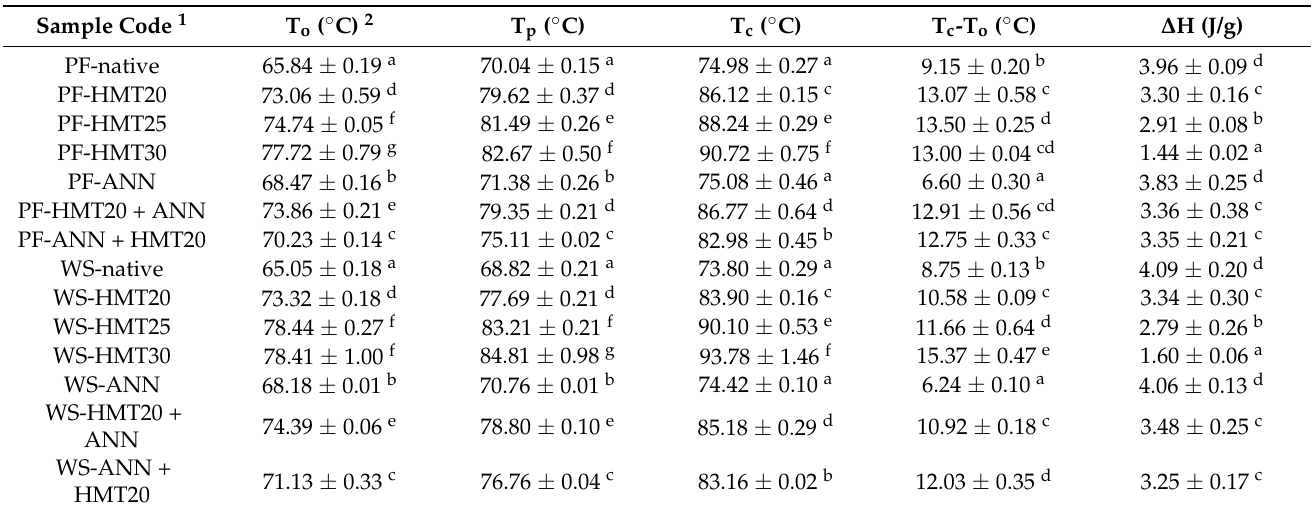
Table 3. Differential scanning calorimetry parameters of native/modified lotus rhizome starches 3